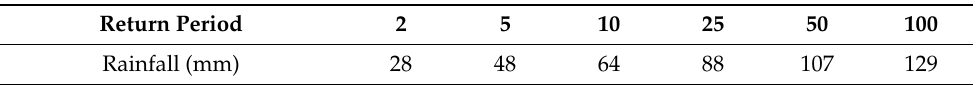
Table 1. Maximum 24-h rainfall (mm) for different return periods for the study area based on LPT III